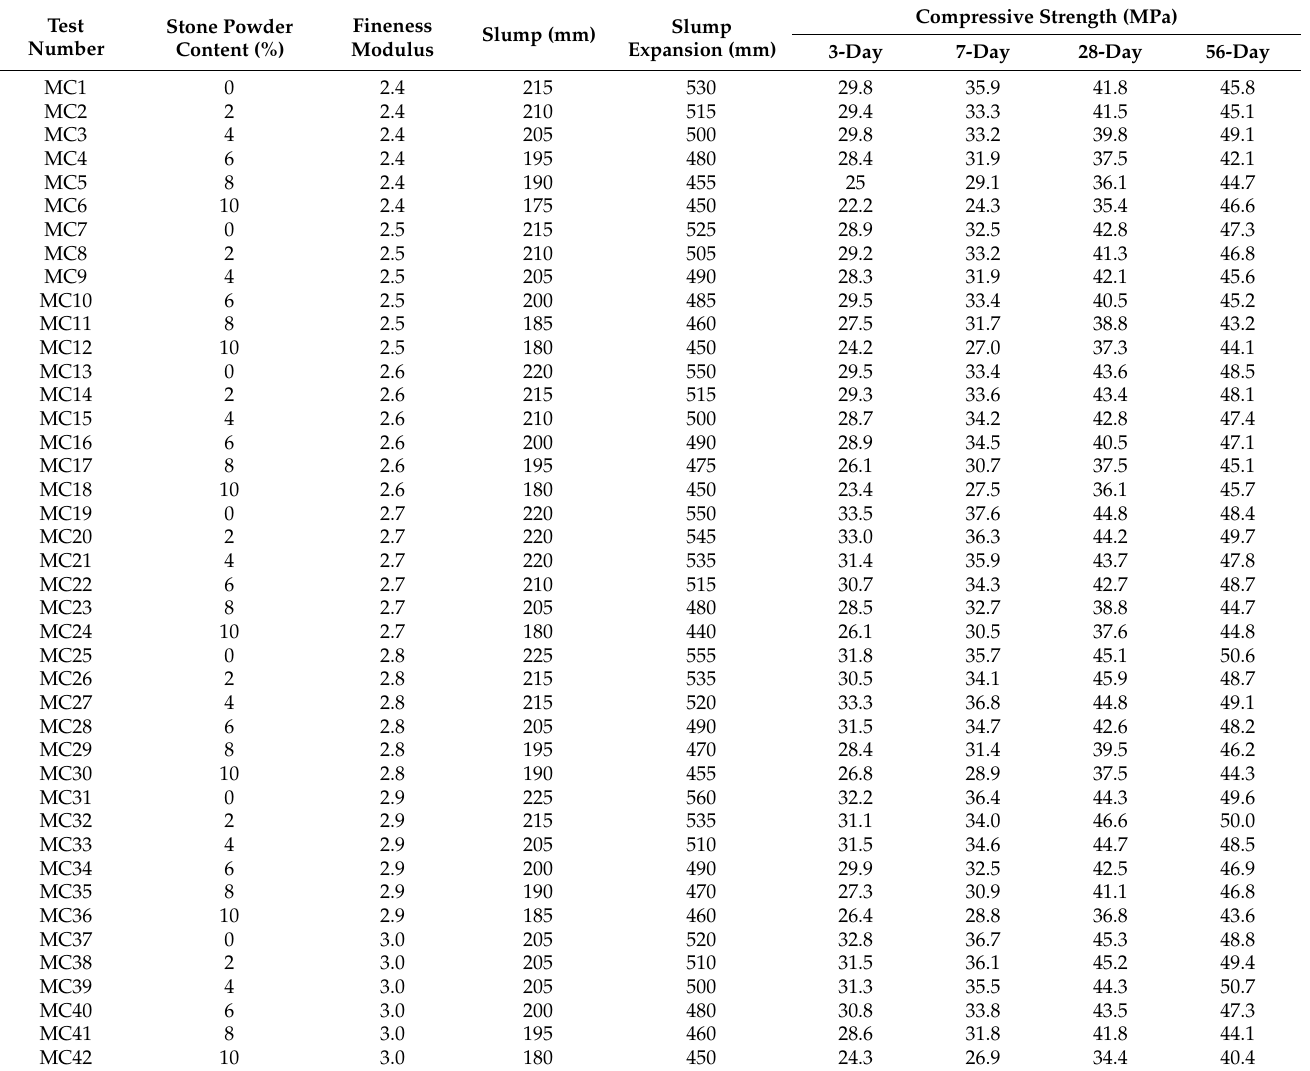
Table 11. Performance test results of machine-made sand concrete with different fineness modulus and stone powder